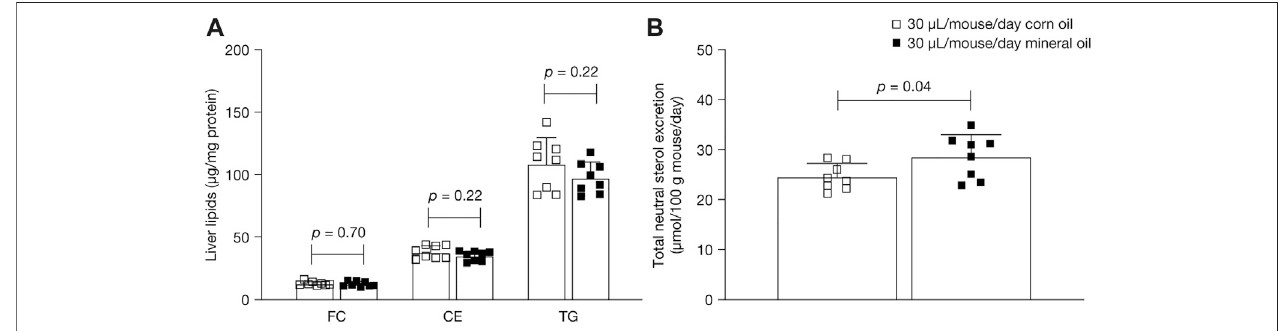
FIGURE 4 | Mean (SD) (A) liver free cholesterol, cholesterol esters, and triglycerides at 16 weeks and (B) total neutral sterols excretion in feces at 15 weeks. p -values were calculated using independent samples t -test. CE, cholesterol esters; FC, liver free cholesterol; SD, standard deviation; TG, triglycerides.